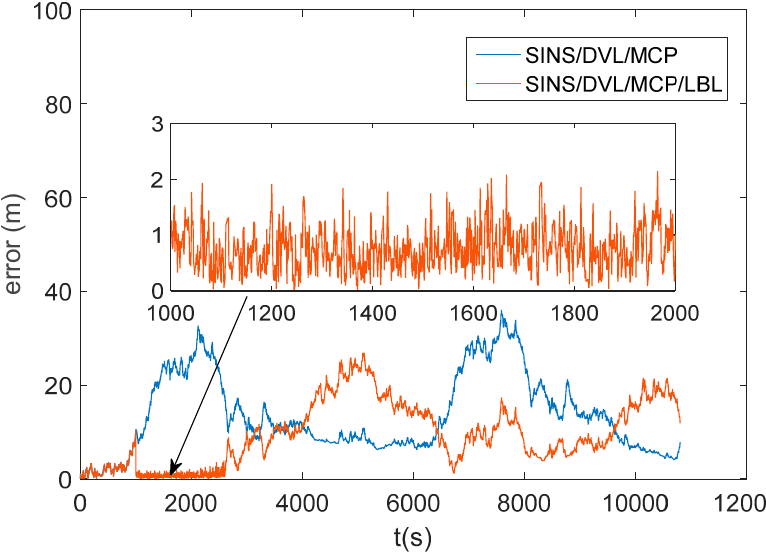
Figure 20. Error comparison of the positioning results.